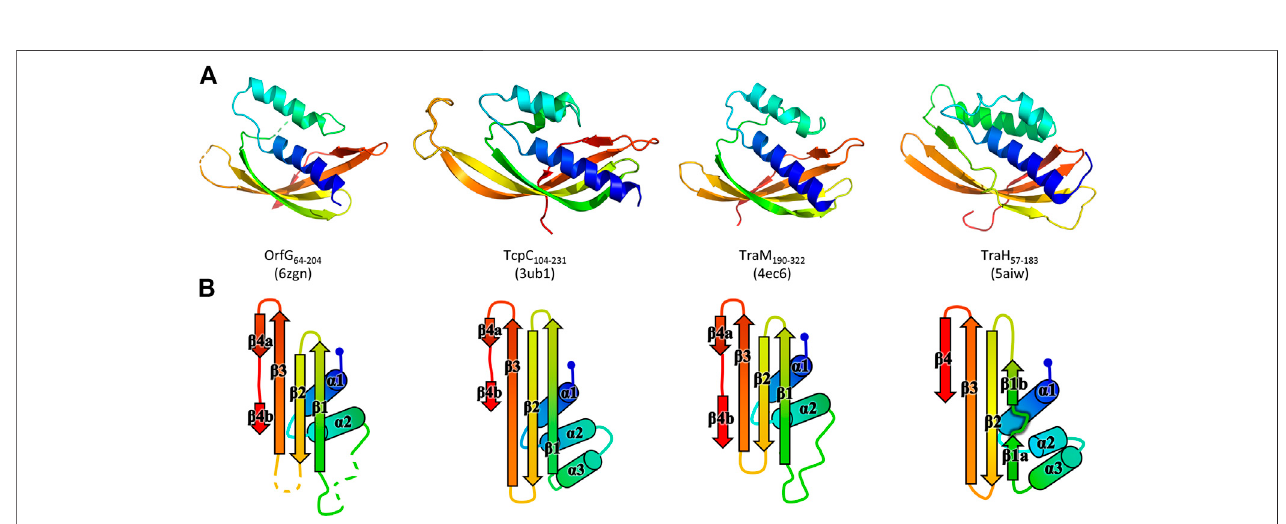
FIGURE 2| Structuresof OrfG 64 – 204 , TcpC 104 – 231 , TraM 190 – 322 , and TraH 57 – 183 . From left to right respectively, the four monomers (PDB id 6zgn, 4ec6, 3ub1, and 5aiw)aredisplayedinthesameorientationandrepresentedasrainbow-coloredcartoons,withtheN-terminalendofthepolypeptidechaininblueandtheC-terminalend in red (A) . Their topology is schematized with the same rainbow-color code and the name of the secondary structures (B) .